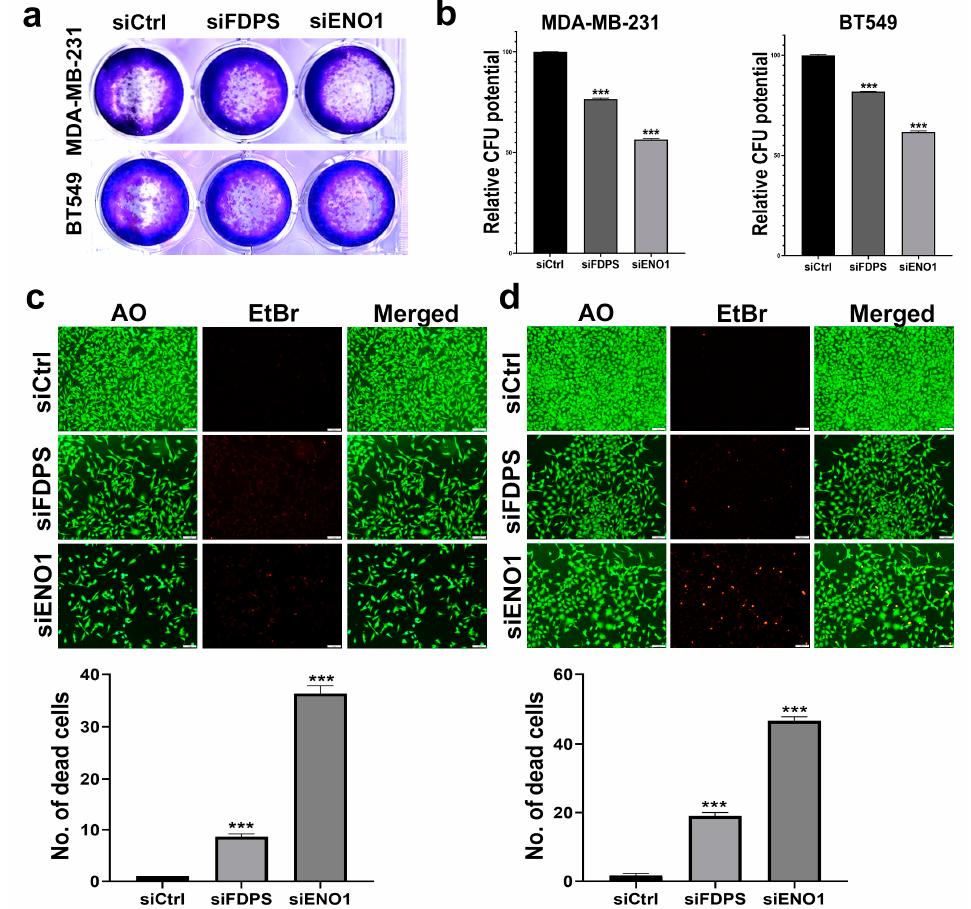
Figure 6. Colony formation and viability assessment of TNBC cells models in response to ENO1 and FDPS depletion. CFU of MDA-MB-231 and BT-549 in response to FDPS and ENO1 depletion ( a ). Quantification of CFU in MDA-MB-231 and BT-549 in response to FDPS and ENO1 depletion ( b ). Data are presented as means ± S.E., n = 3. *** p < 0.0005. Upper panels show representative live (green) and dead (red) staining of MDA-MB-231 ( c ) and BT-549 ( d ) in response to FDPS and ENO1 depletion. (Scale bar = 1000 µ M). Quantification of the number of dead (red) cells under each treatment condition is shown in lower panels. Data are shown as mean number of dead cells in three di ff erent fi elds (10×) ± S.D, n = 3. *** p < 0.0005.